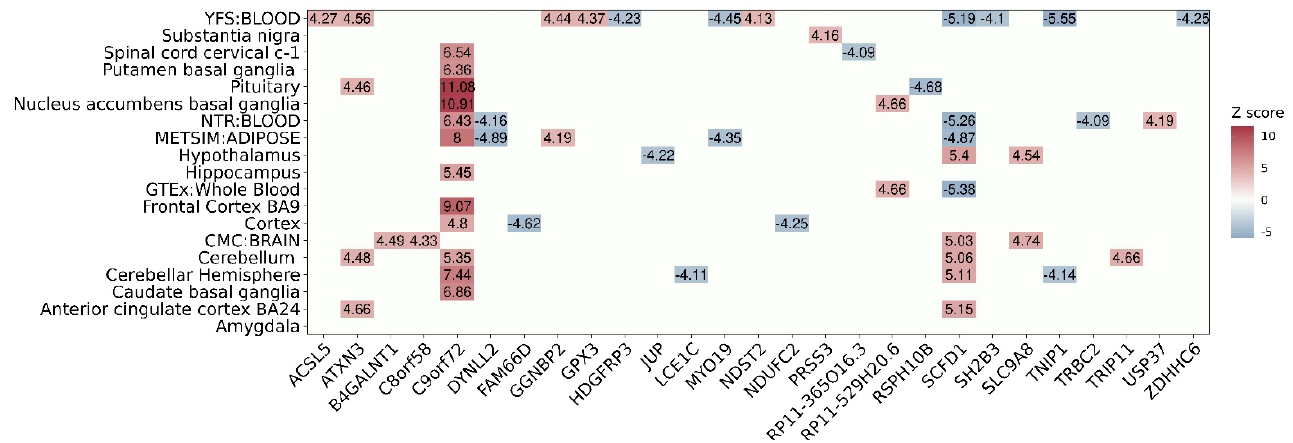
Figure 3. Heatmap showing the predicted expression patterns of TWAS significant associations. The x-axis represents the 27 significant TWAS genes and the y-axis indicates 19 SNP-GE weights. The Z-score values are labeled on the plot and are represented by a color bar on the right.